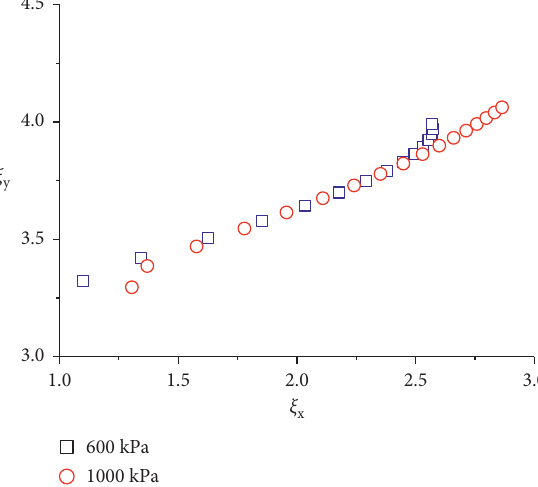
Figure 6: Conventional triaxial test of granite rockfills [16].